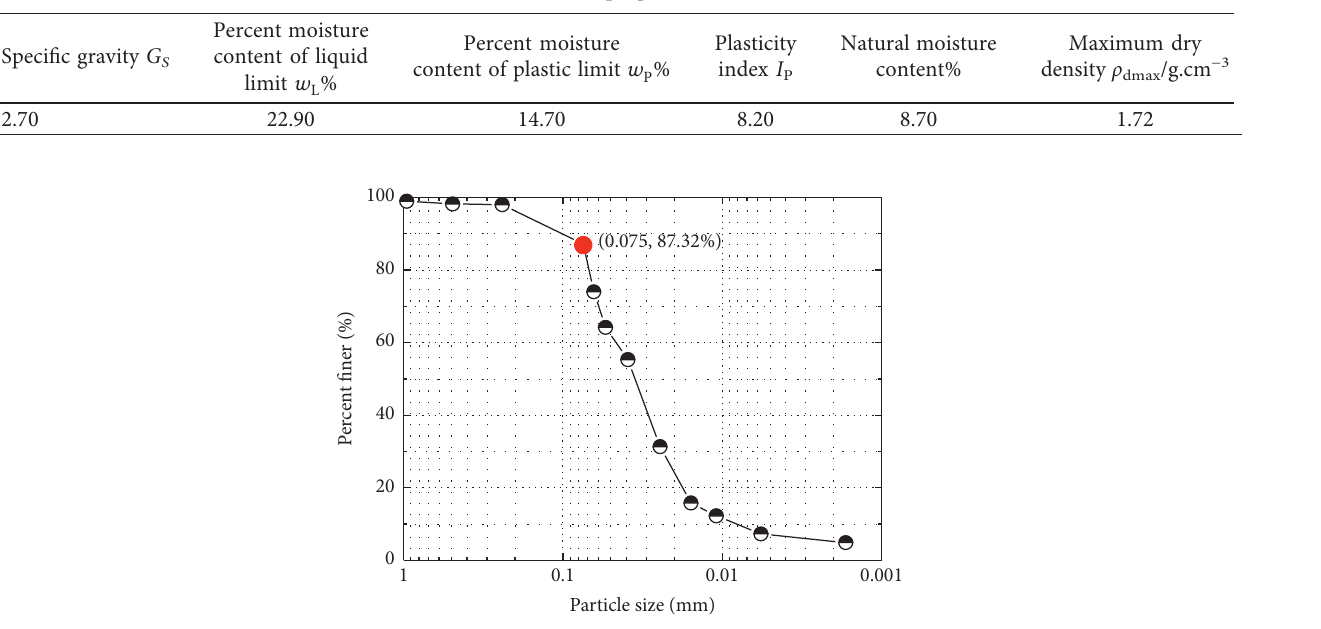
Table 1: Intrinsic properties of the soil.